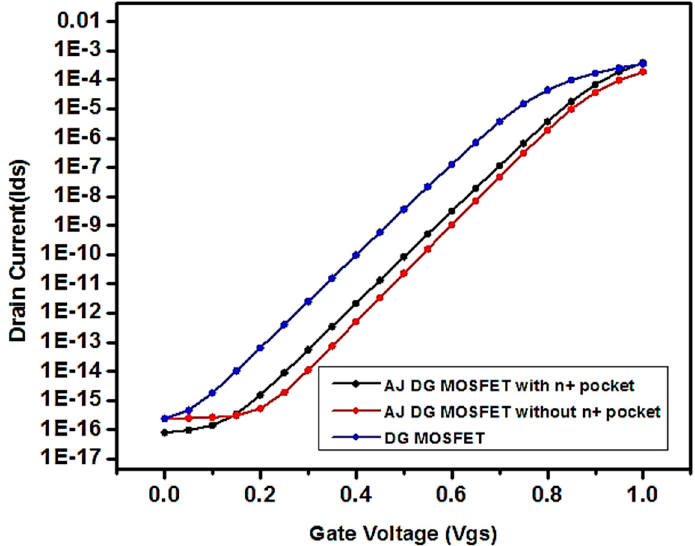
Figure 3. Drain current variations concerning gate voltage for heavily doped n + pocket AJ DG MOSFET. Table 2. Performance comparison of proposed n + pocket AJ DG MOSFET with available DG MOSFET device structures.